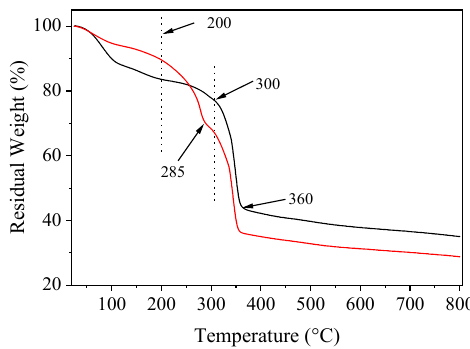
Figure 4. Thermogravimetric analysis of HKUST-1 (black) and TEBAC-HKUST-1 (red).